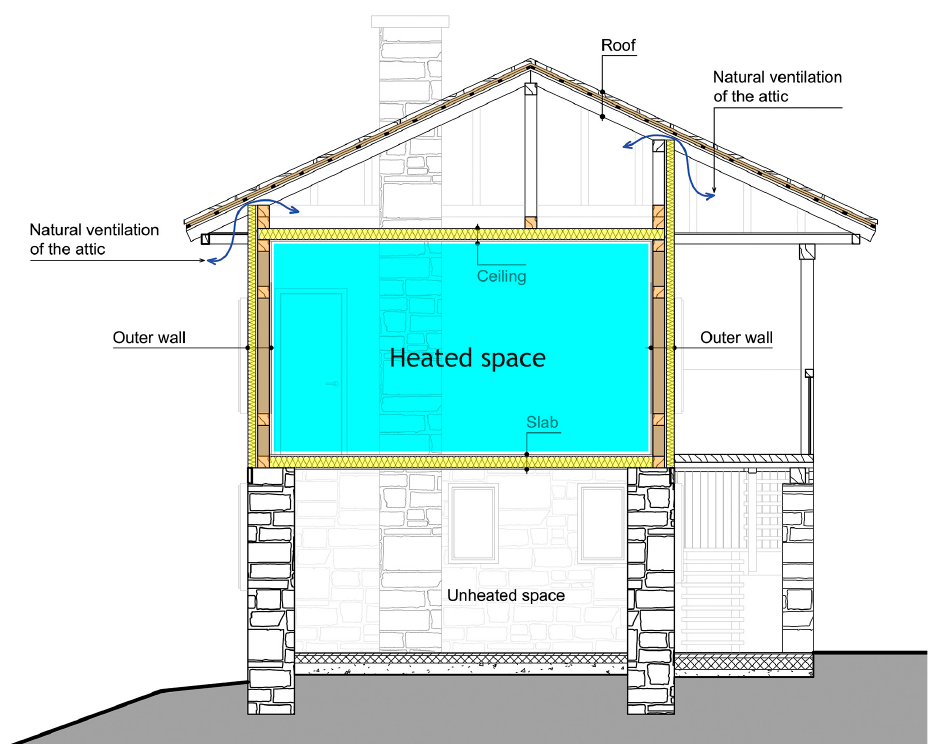
Figure 4. Renovation: Section plan.